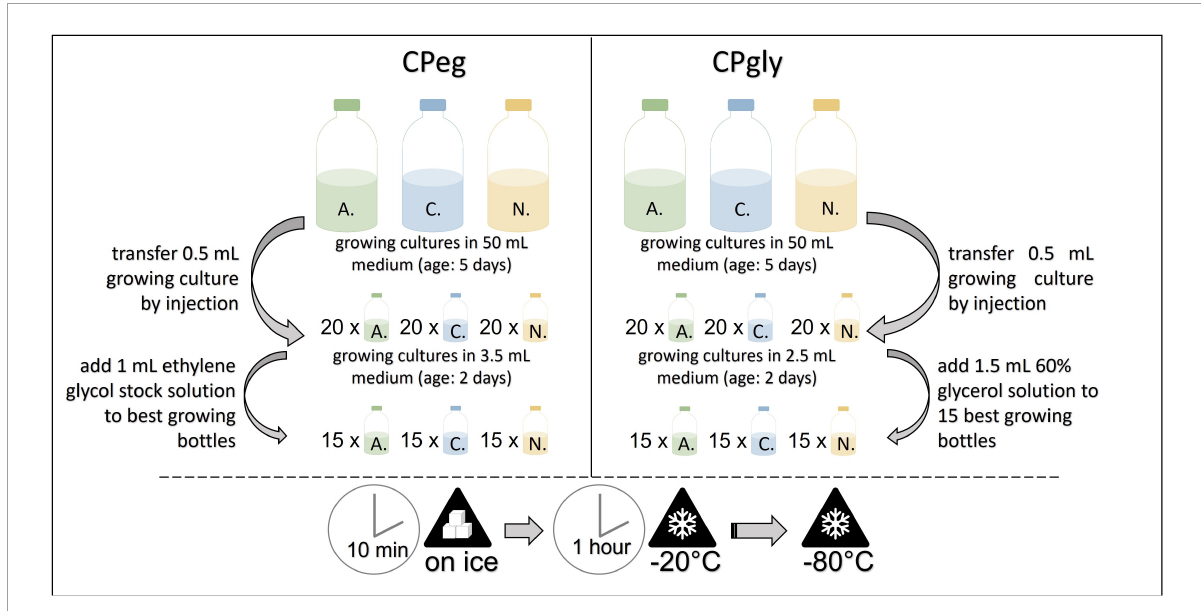
FIGURE3 Workflow for the cryopreservation protocols CPeg (left) and CPgly (right) . A. , Anaeromyces mucronatus ; C., Caecomyces sp.; N., Neocallimastix cameroonii. CPeg, cryopreservation protocol with ethylene glycol stock solution; CPgly, cryopreservation protocol with glycerol stock solution.